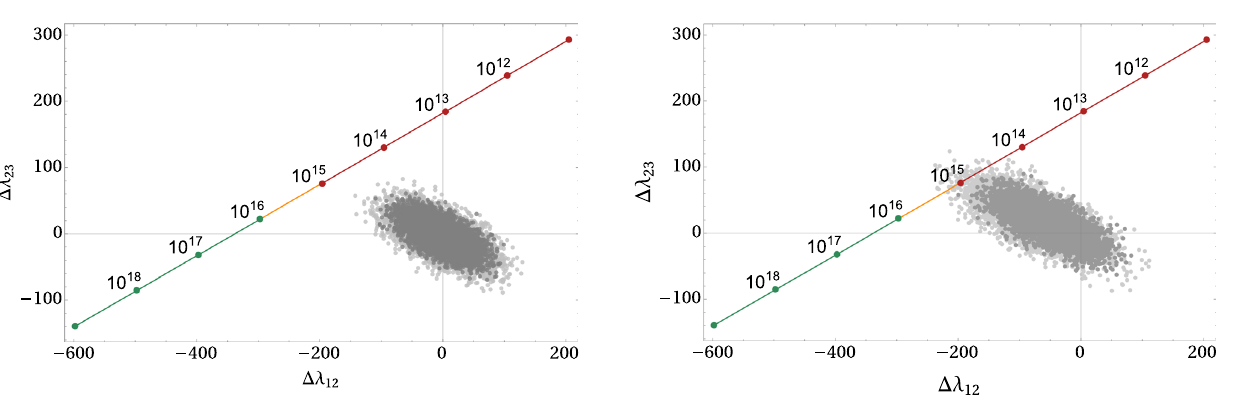
Fig. 4. The decomposition of the scalar representations and the resulting threshold formulas are given in Appendix A.2.